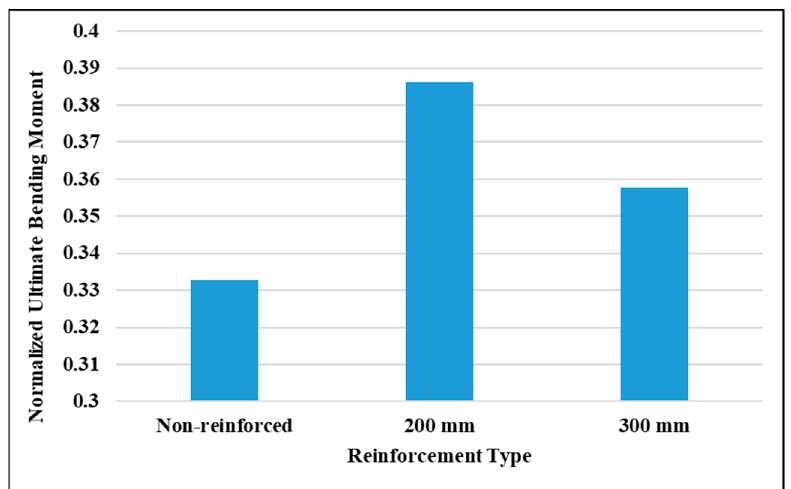
Figure 15. The ultimate normalized moment for major axis test with respect to the reinforcement type.